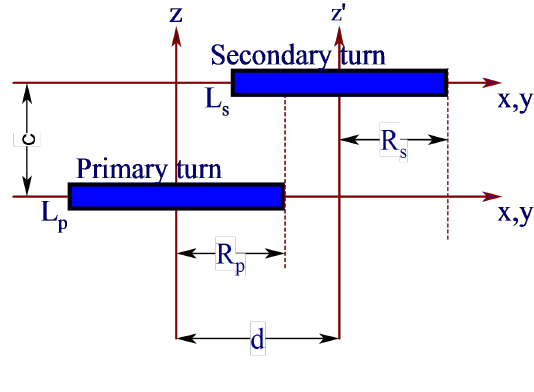
Figure 4. Circular coils with vertical and horizontal